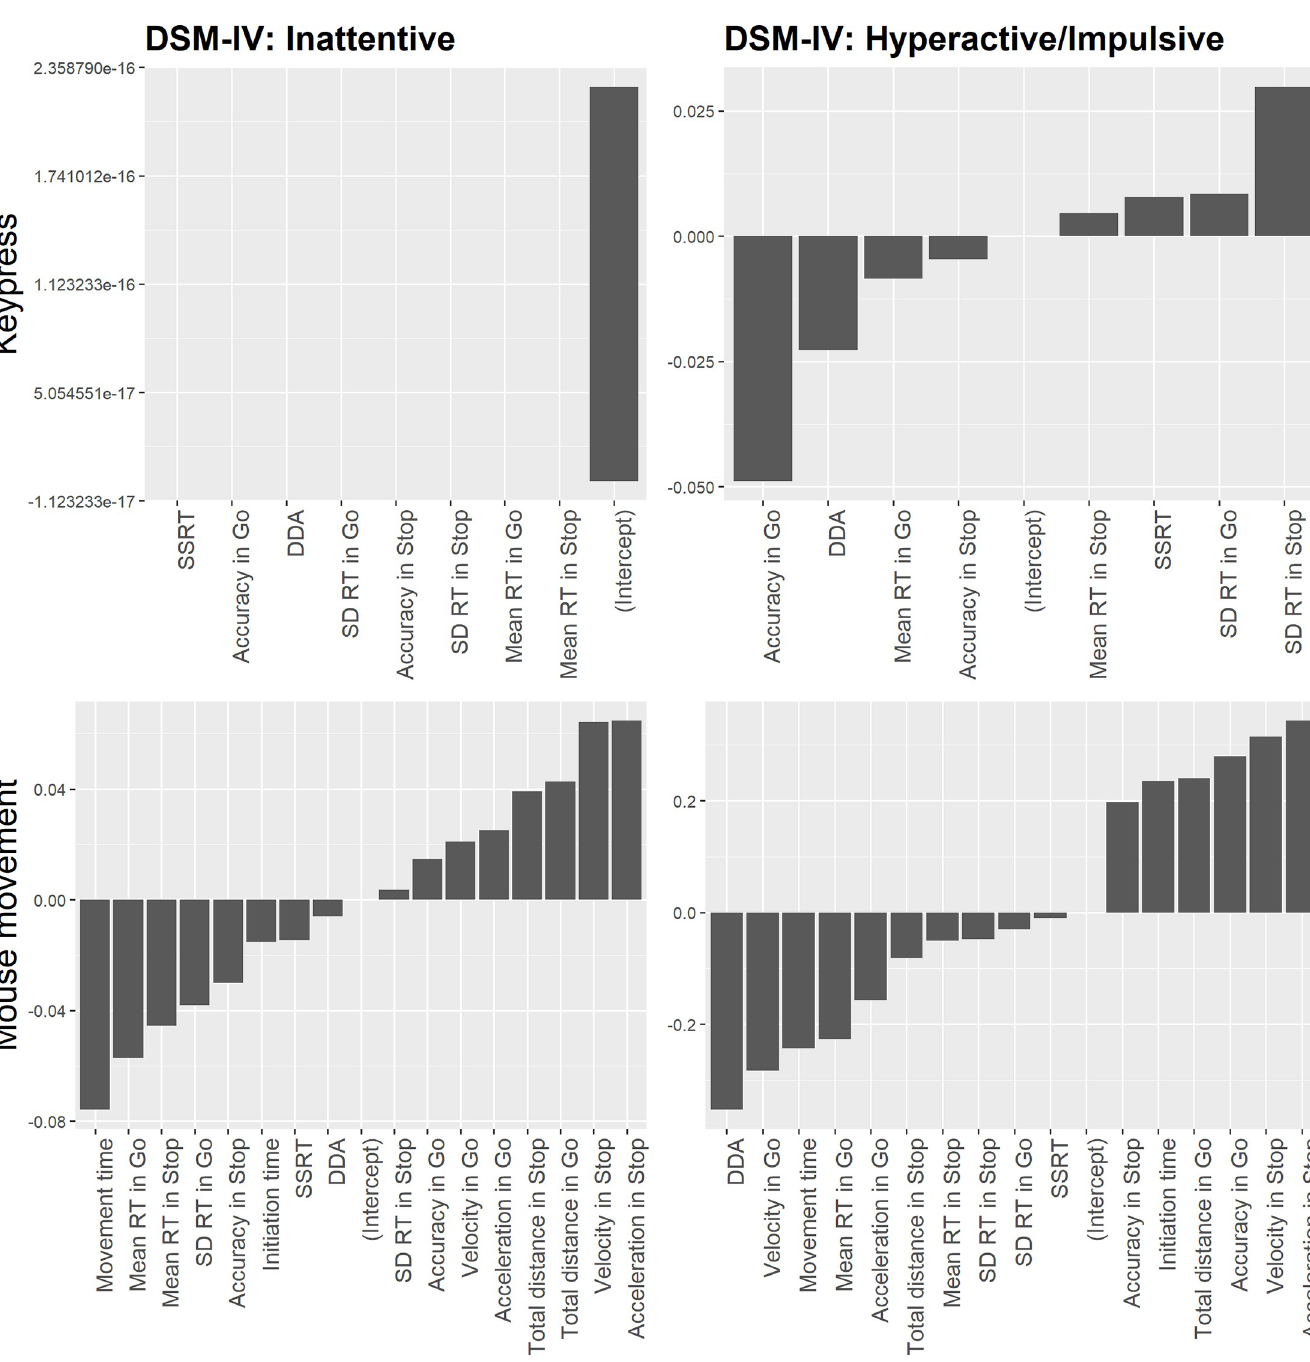
Fig 6. Ridge regression coefficients in keypress and mouse movement conditions. Coefficient value closer to zero indicates less importance. DDA = Direction discrimination